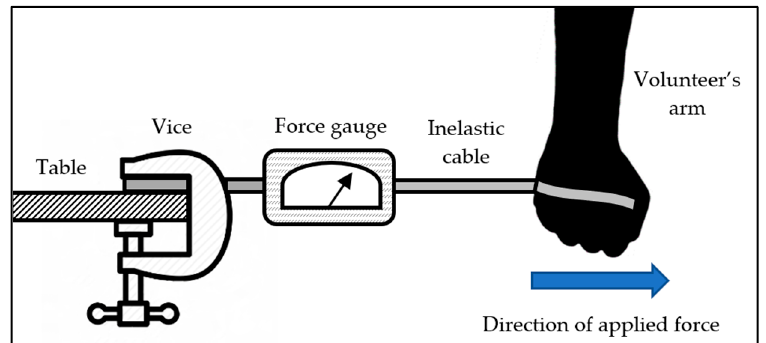
Figure 2. Experimental setup to measure release forces.